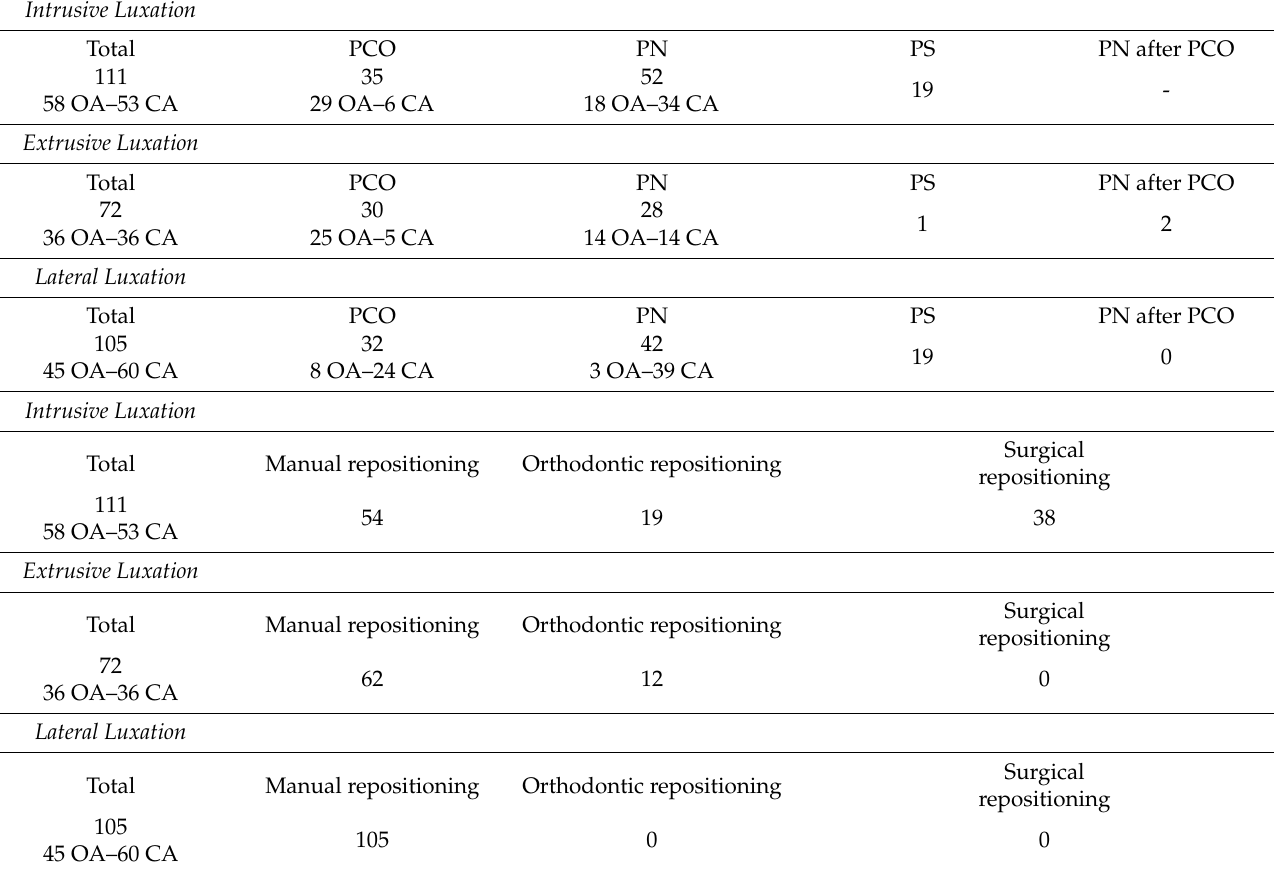
Table 4. The table shows the pulp responses after luxation injuries and the therapeutic approach